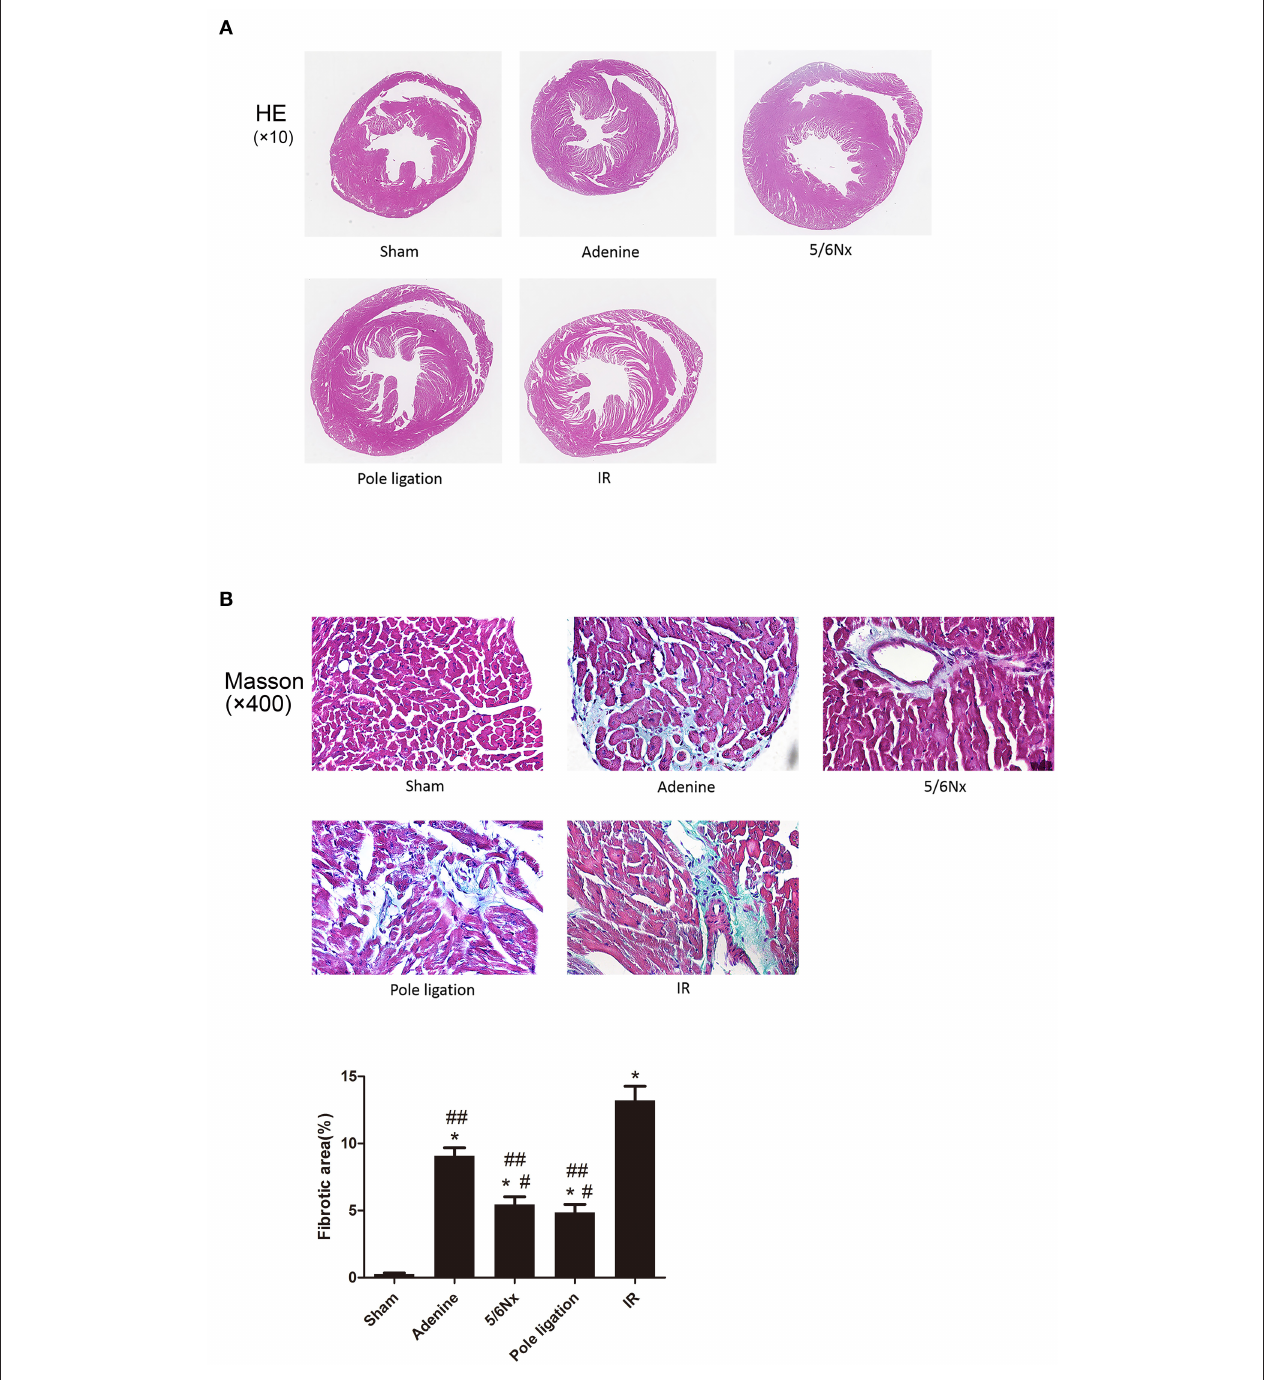
FIGURE 3 | Comparisons of cardiac histology changes in different models in CKD mice. (A) Representative micrographs of transverse sections (HE). (B) Representative micrographs of left ventricular sections (Masson). * P < 0.001, vs. Sham; # P < 0.01 vs. adenine group; ## P < 0.001 vs. IR group.